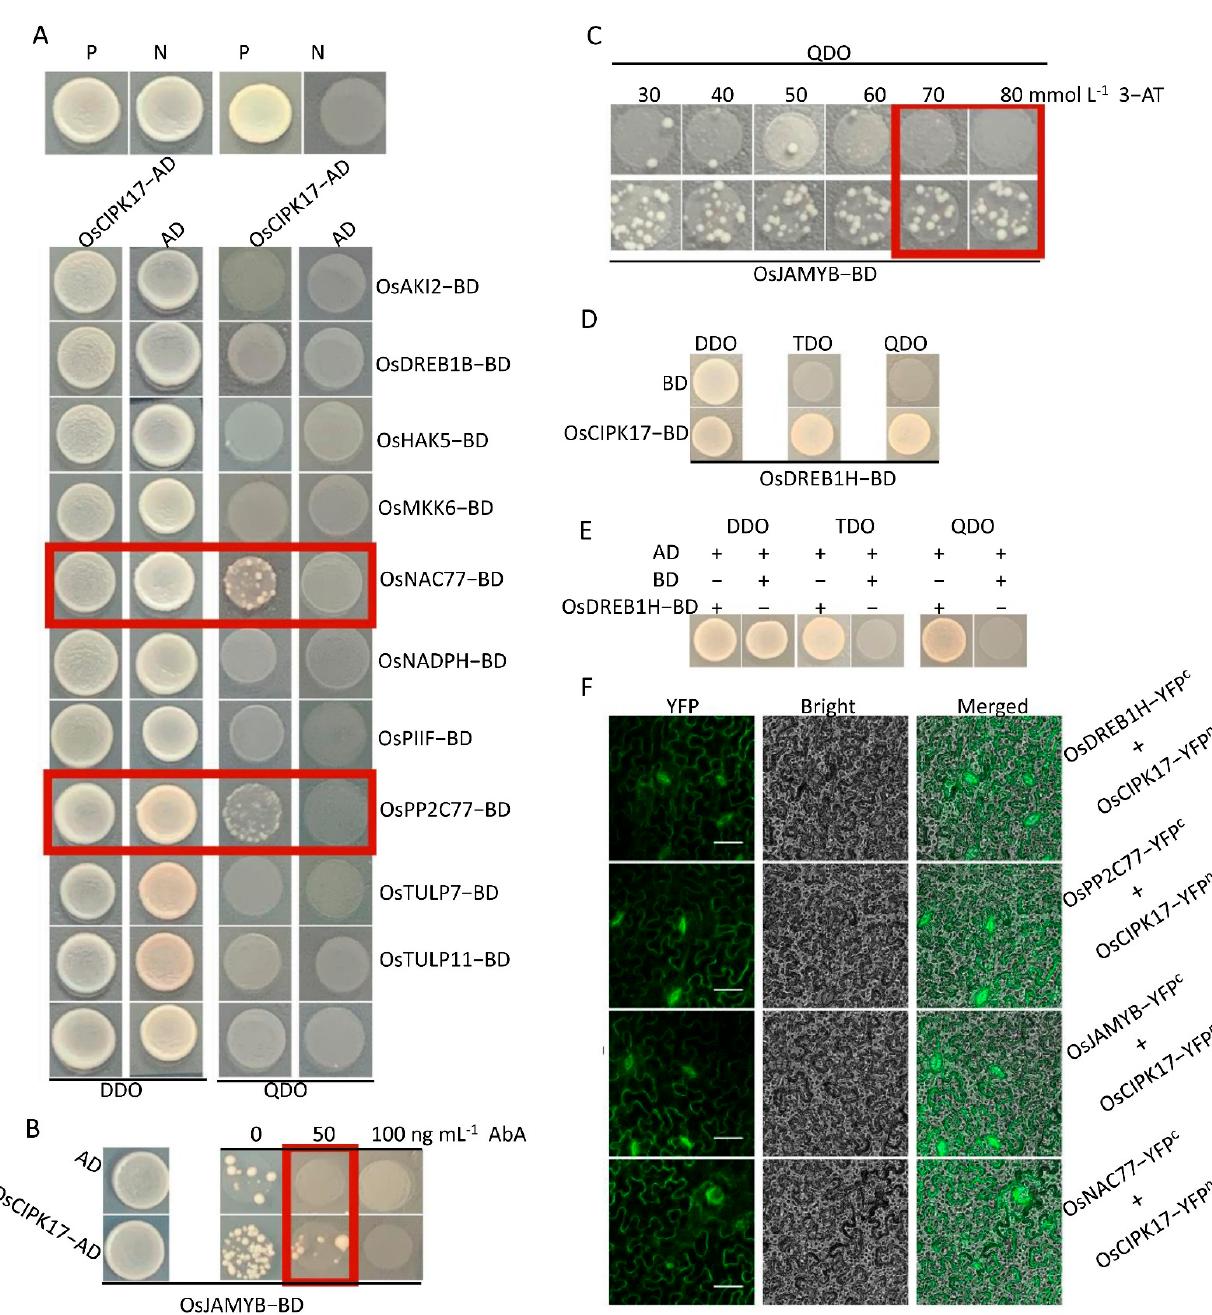
Figure 6. OsCIPK17 can interact with OsPP2C77, OsJAMYB, OsDREB1H and OsNAC77. ( A ) The Y2H experiment verified the target protein that may have a regulatory relationship with OsCIPK17. P: positive control; N: negative control. ( B , C ) Y2H experiment verified that OsCIPK17 can interact with OsJAMYB. Aureobasidin A (AbA) and 3-amino-1, 2, 4-triazole (3-AT) were added to QDO medium to inhibit self-activation. ( D ) The Y2H experiment verified that OsCIPK17 can interact with OsDREB1H. ( E ) Detection of trans-activatory activity of OsDREB1H. A plus sign indicates that the ingredient has been added, and a minus sign indicates the opposite. ( F ) BiFC experiments verified that OsCIPK17 can interact with OsNAC77, OsJAMYB, OsPP2C77 and OsDREB1H, respectively. Bar = 100 μ m.